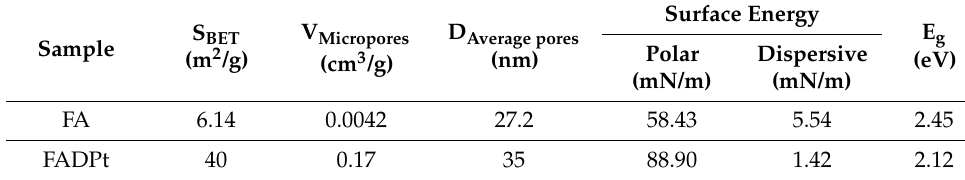
Table 2. Surface characteristics of FA and FADPt.